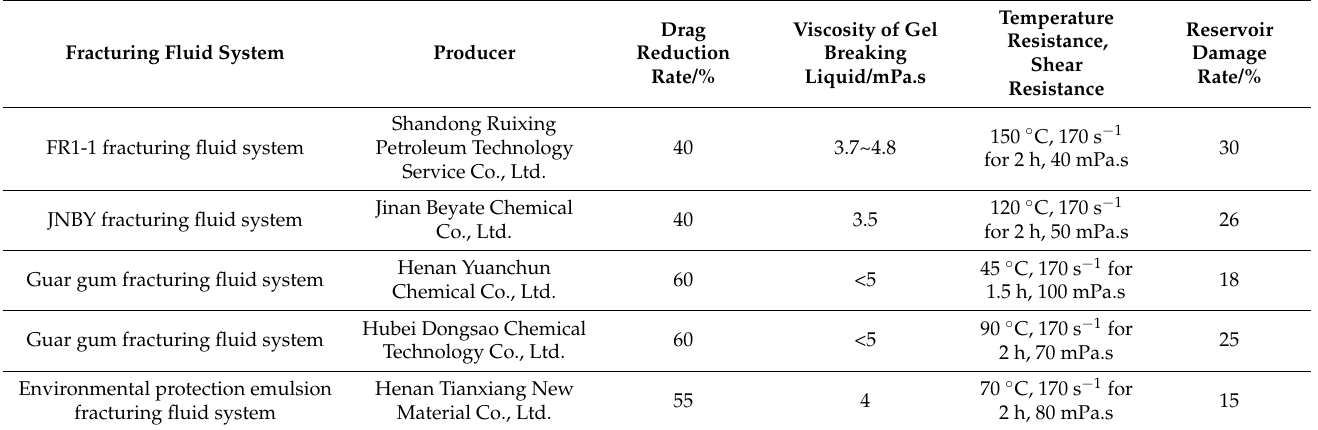
Table A2. Performance comparison table of fracturing fluid systems on the market and the ZJL-1 fracturing fluid